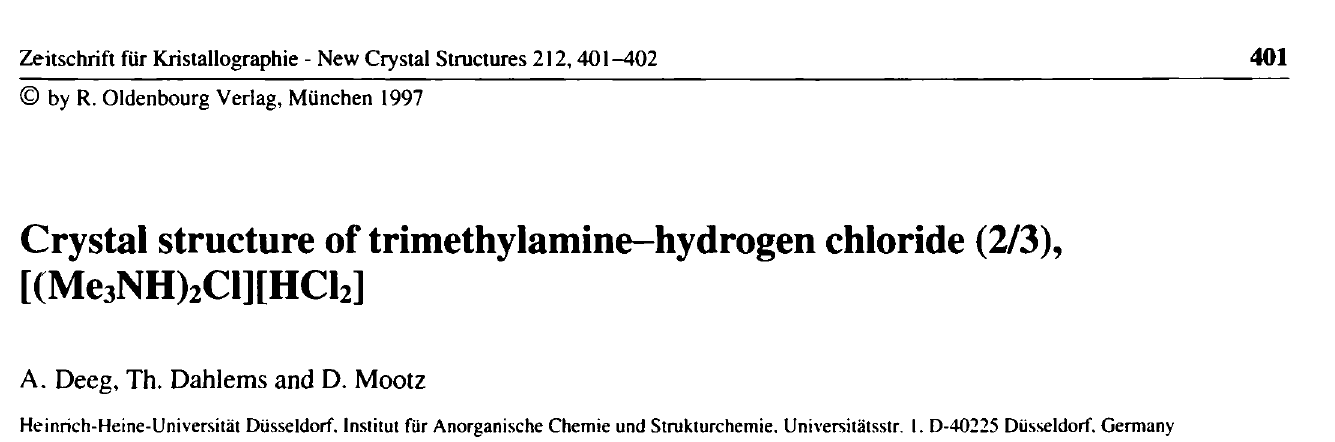
Table 1. Parameters used for the X-ray data collection